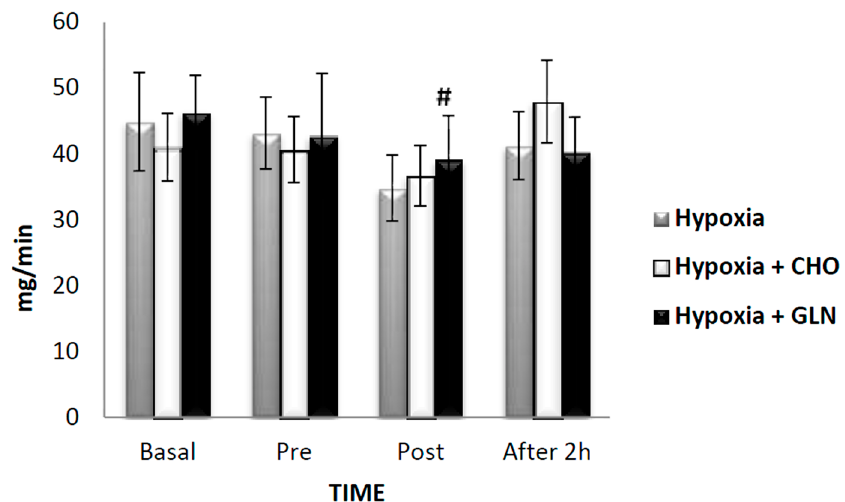
Figure 3. The results of secretory immunoglobulin A (IgA) (mg/min) was described by mean ± Standard Error (SE). The interaction of group versus time was analyzed by Analysis of Variance (ANOVA) for repeated measures followed by post hoc of Tukey test. The level of significance was set at p < 0.05. n = 15 volunteers. # Statistically significant in relation to basal. Hypoxia + CHO = Hypoxia + carbohydrate and hypoxia + GLN = hypoxia + glutamine.